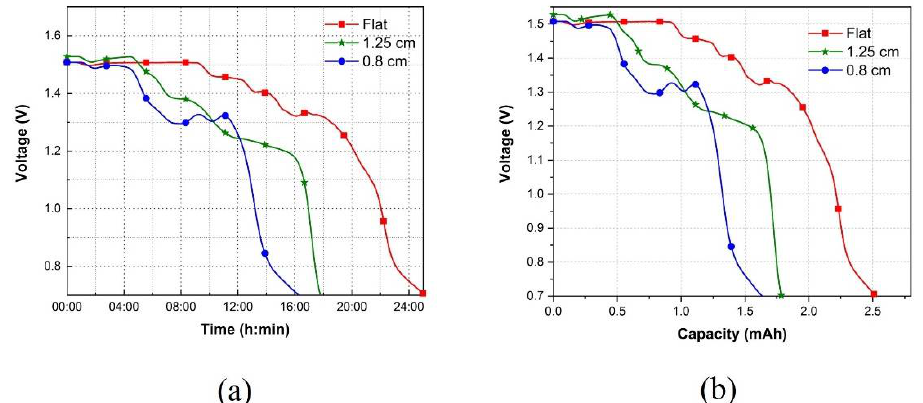
Figure 10. Discharge characteristics of the flexible battery when flexed to different radii of curvature while discharging at 0.1 mA . ( a ) Discharge voltage versus time; and ( b ) discharge voltage versus capacity.